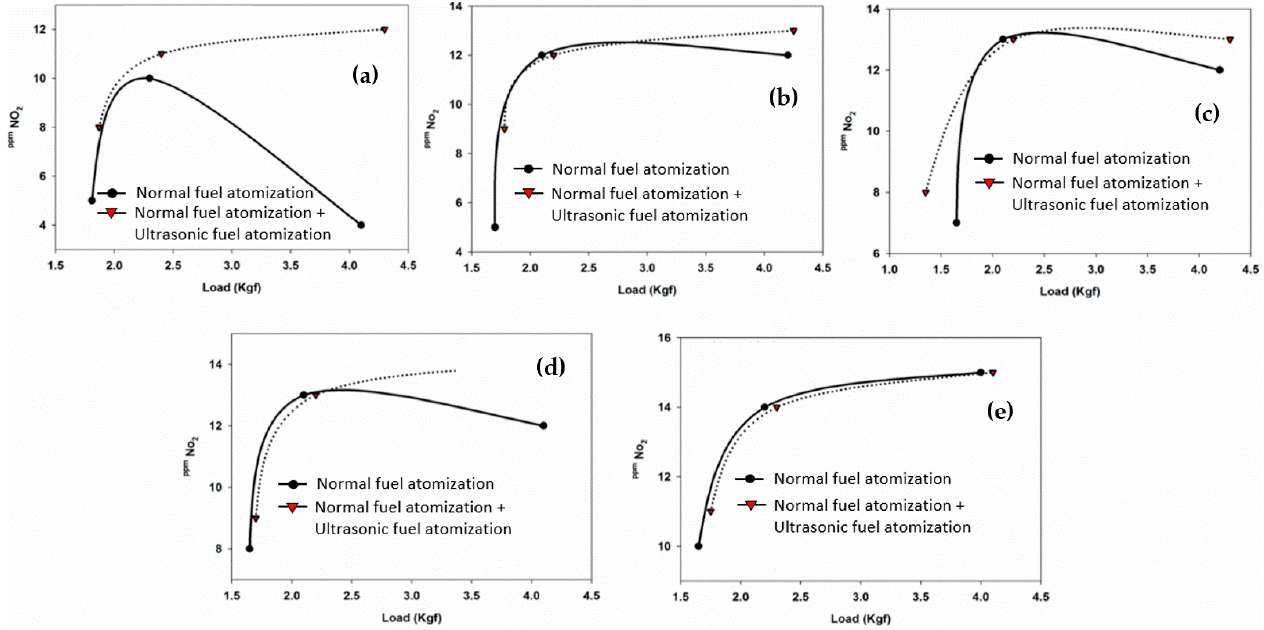
Figure 7. Plots of NO emissions against the engine load for all the different fuel types: ( a ) kerosene, ( b ) B20, ( c ) B50, ( d ) B75 and ( e ) B100.